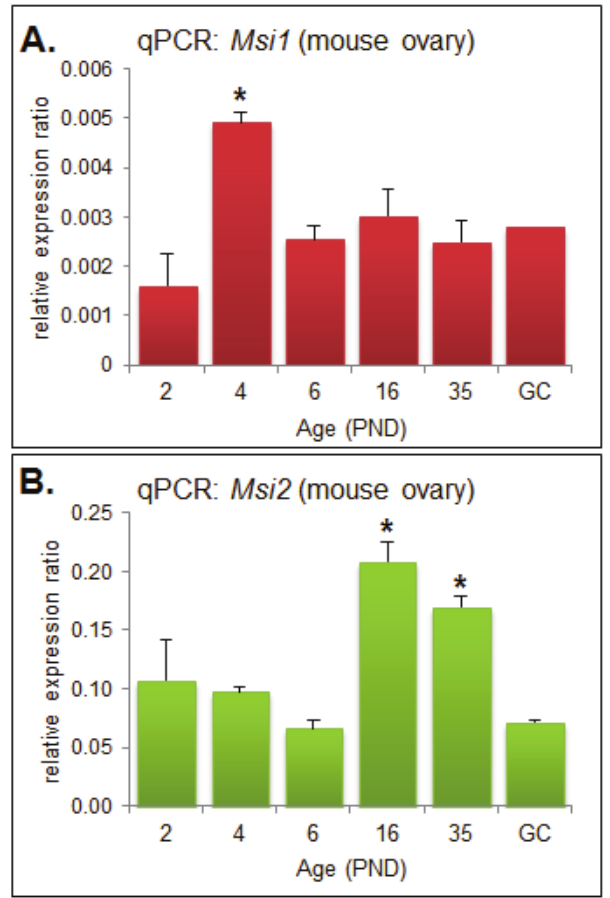
Figure 1. Quantitative PCR (qPCR) Analysis of Musashi during ovary maturation . ( A ) QPCR of Msi1 in ovary time-course from post-natal day (PND) 2 through to sexual maturity at PND35 and in isolated granulosa cells (GC). MRNA expression relative to Cyclophilin A (2e(cid:2)Ct); values are mean + SEM; (ovary: n = 3, GC: n = 2). ( B) QPCR of Msi2 in ovary time-course from PND 2 through to PND35 and in isolated granulosa cells (GC). Fold change relative to Cyclophilin A (2e(cid:2)Ct); values are mean + SEM; (ovary: n = 3, GC: n =